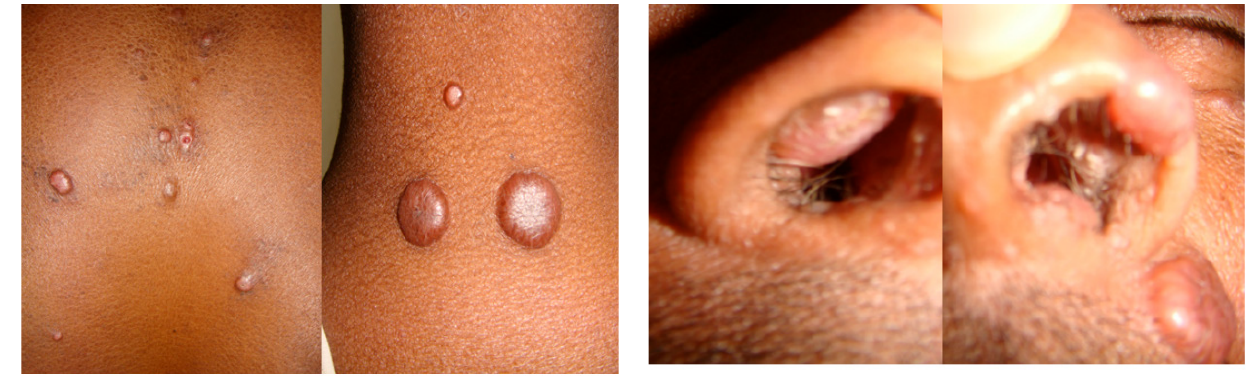
Figure 1A: Multiple skin-colored papules and nodules distributed over back and neck. B. Similar types of papules and nodules inside the nose.